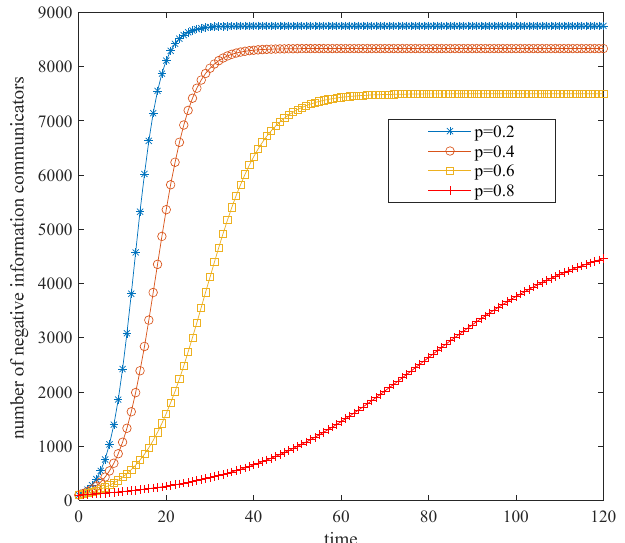
Figure 4. The spread of COVID-19 public opinion under positive emotional tendencies.